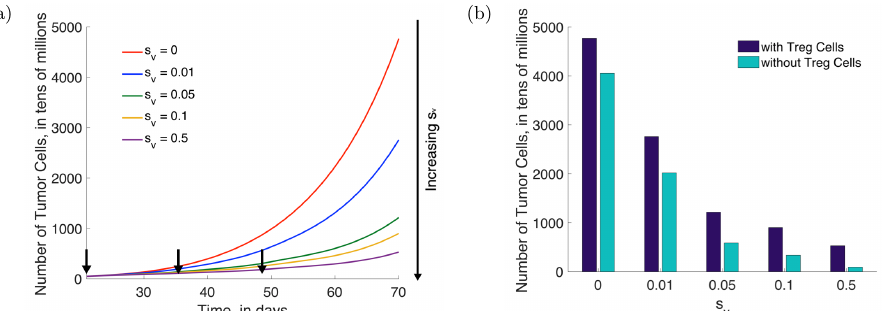
Figure 1: Local sensitivity anaylsis of parameter values not taken from the literature. In (a) Figure 4. Treatment of xenografts with Provenge alone. ( a ) Predicted tumor cell time courses after we plot the percent change in the sum of squares versus the fold change in tumor dynamics treatment with Provenge, as dose strength is varied. Control is shown in red. ( b ) Comparison of the equations parameters over the baseline. In (b) we plot the percent change in the sum of squares predicted final tumor cell numbers, with (dark bars) and without (light bars) the presence of Tregs, as versus the fold change in PSA dynamics equations parameters over the baseline. dose strength of Provenge is